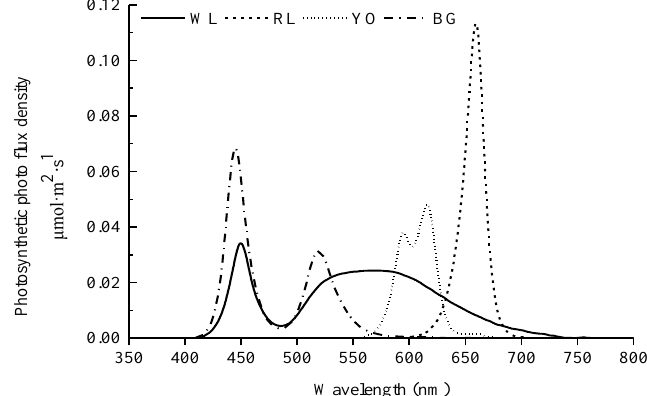
Figure 2. Light spectral distribution of four light-emitting diode (LED) lights (WL: white, RL: red, YO: yellow-orange, BG: blue-green).